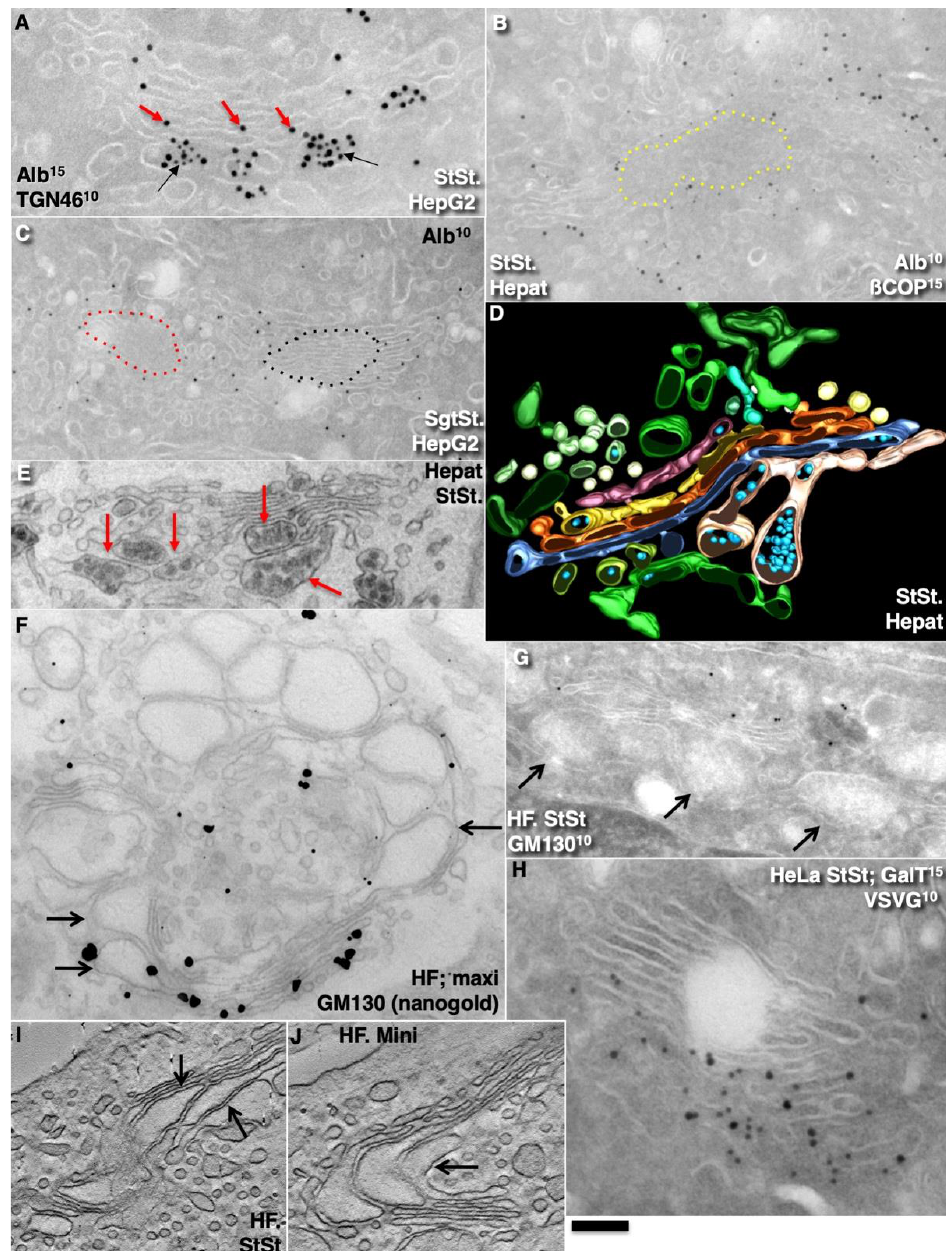
Figure 3. Representative images show enrichment of cargoes at the trans-side of the Golgi complex. The type of cell, protein labelling and the state of transport (steady-state [StSt]; mini-wave [Mini]) are indicated on the images. ( A ) Enrichment of albumin (red arrows) in the last medial cisterna and in TMC (black arrows). Tokuyasu cryo-section. ( B , C ) Enrichment of albumin in the cisternal lumen near the rims. Tokuyasu cryo-section. ( D , E ) Enrichment of VLDL in one cisternal distension of a hepatocyte. ( D ) Three-dimensional model of EM tomography. ( E ) Routine transmission EM. ( F ) High concentration of PCI distensions (arrows) in the last medial cisternae of human fibroblasts. Enhanced nanogold. ( G ) Enrichment of procollagen I (PCI) distensions (arrows) at the trans-side of the Golgi. Tokuyasu cryo-section. ( H ) Enrichment of VSVG labelling (10 nm gold) at the trans-side of the Golgi stack. Tokuyasu cryo-section. ( I ) Enrichment of PCI distensions (arrows) within the last medial cisternae in human fibroblasts at steady-state. EM tomography. ( J ) Enrichment of PCI distensions (arrows) in the medial cisternae at the trans-side of the Golgi complex of human fibroblasts under a mini-wave. EM tomography. Scale bars: 130 nm ( A , D , H ); 200 nm ( B , C , E ); 240 nm ( F , G , I , J ).